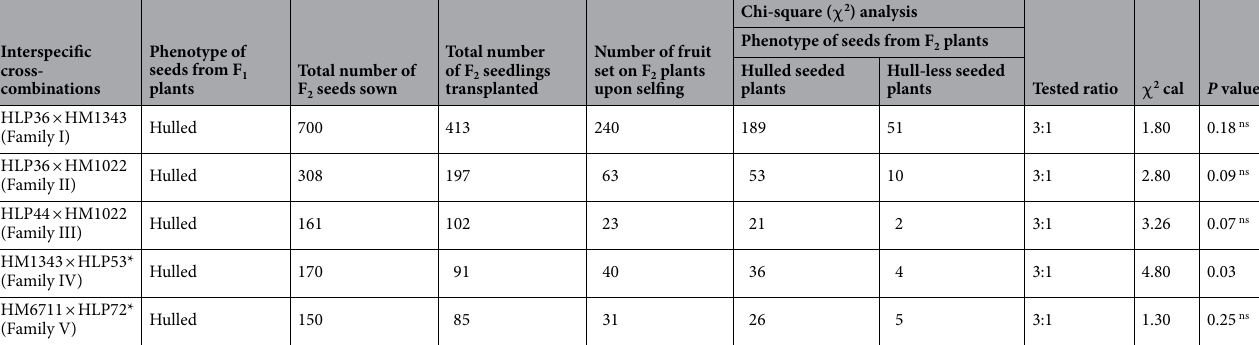
Table 6. Segregation of hull-less seeds in F 1 and F 2 populations of interspecific crosses. *Derived through ovule culture. At 5% level of significance and 1 df, χ 2 = 3.84. ns non-significant.